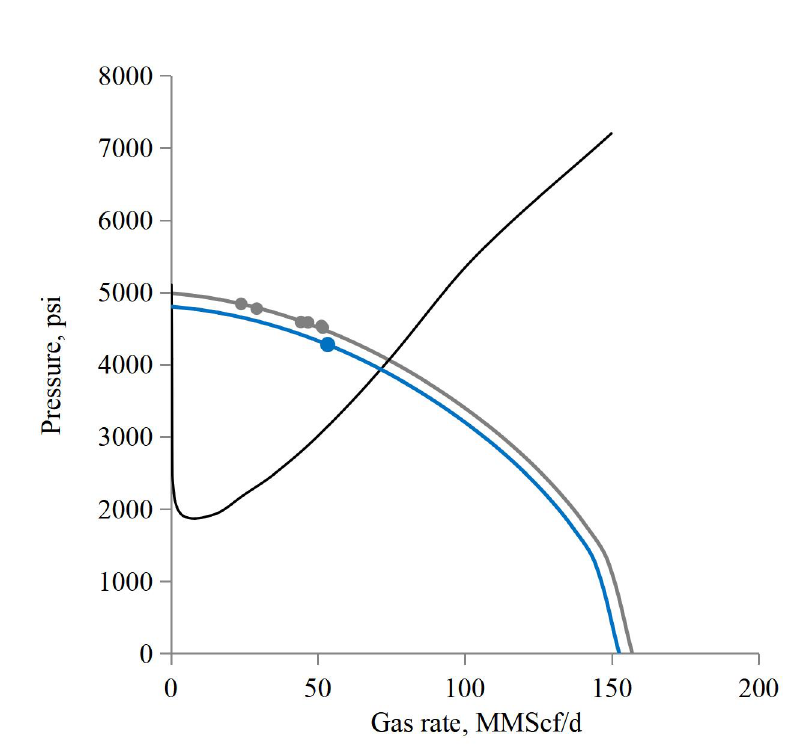
Figure 15—Well Performance from History